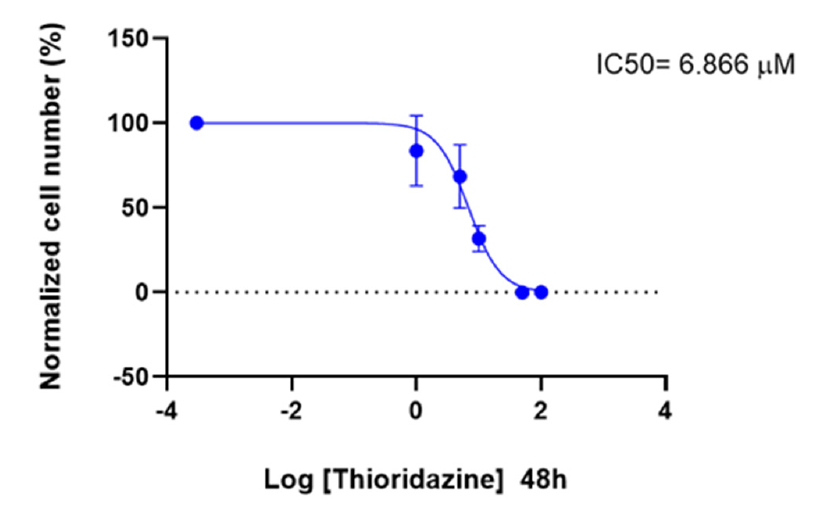
Figure 12. Representation of thioridazine dose-response curve at 48 h. The curve represents a normalization between 0 and 100%, where 100% was defined as the concentration of the drug that least affected the cell viability, and 0% was considered the concentration that most affected the cell viability. Results are expressed as mean ± standard error of the mean (SEM). The IC50 value was calculated using the normalized data (between 0% and 100%).